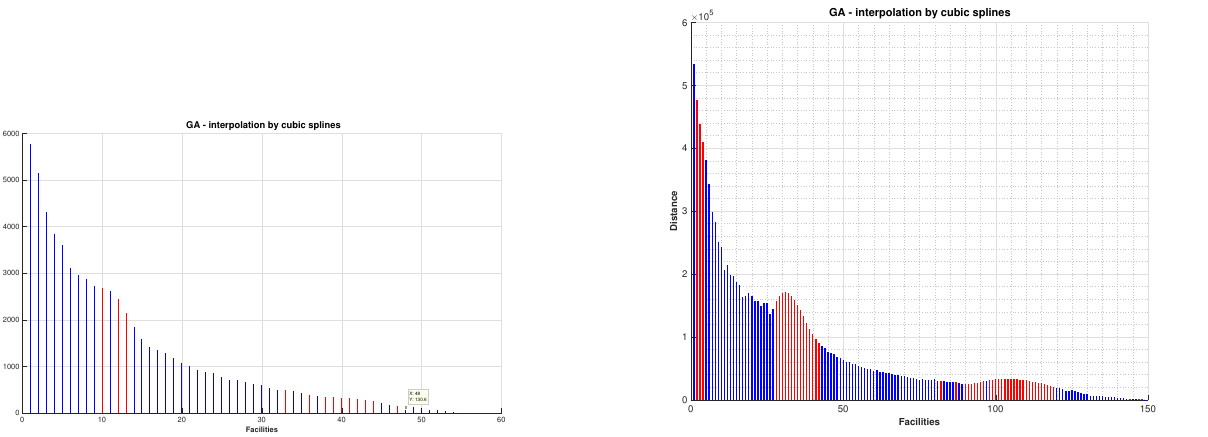
Figure 8. The Pareto set after solving the FLP complemented via exponential regression for: the Swain dataset ( left ), and the London dataset ( right ).